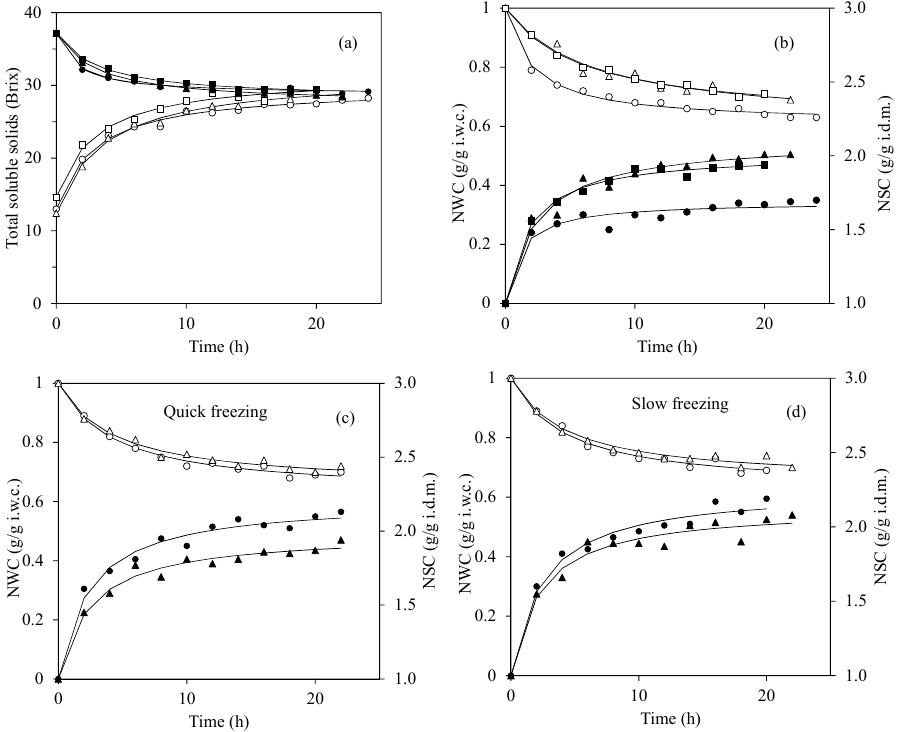
Figure 1. Changes in ( a ) total soluble solids (TSS) content of mango slabs (open symbols) and osmotic solution (closed symbols) and ( b ) NWC (open symbols) and NSC (closed symbols) during the osmotic dehydration of fresh ( , • ), quick frozen ( (cid:52) , (cid:78) ), and slow-frozen ( (cid:3) , (cid:4) ) mango slabs. Changes in NWC (open symbols) and NSC (closed symbols) during the osmotic dehydration of ( c ) quick frozen and ( d ) slow frozen for 1 ( , • ) and 2 month ( (cid:52) , (cid:78) ). Lines were drawn using Peleg’s model. (cid:35)